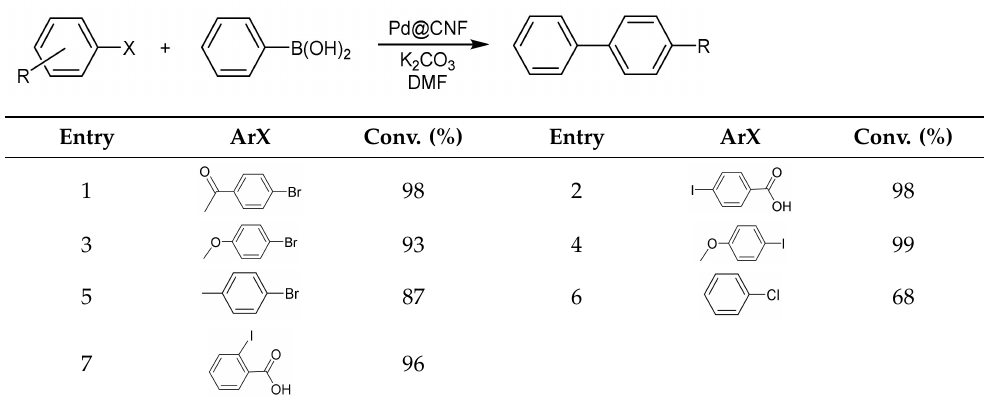
Table 14. Suzuki coupling using Pd@CNF